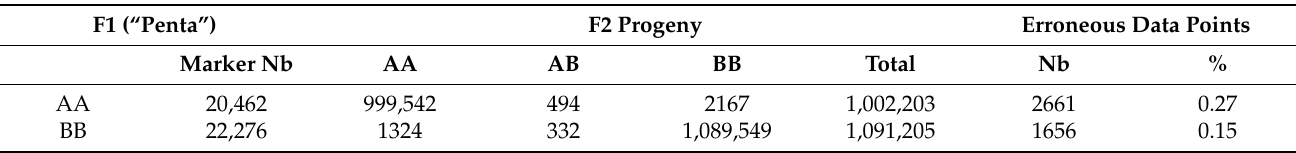
Table 7. Number of monomorphic SNPs in the F1 Penta and erroneous data points in the 49 hybrids of the F2 progeny.